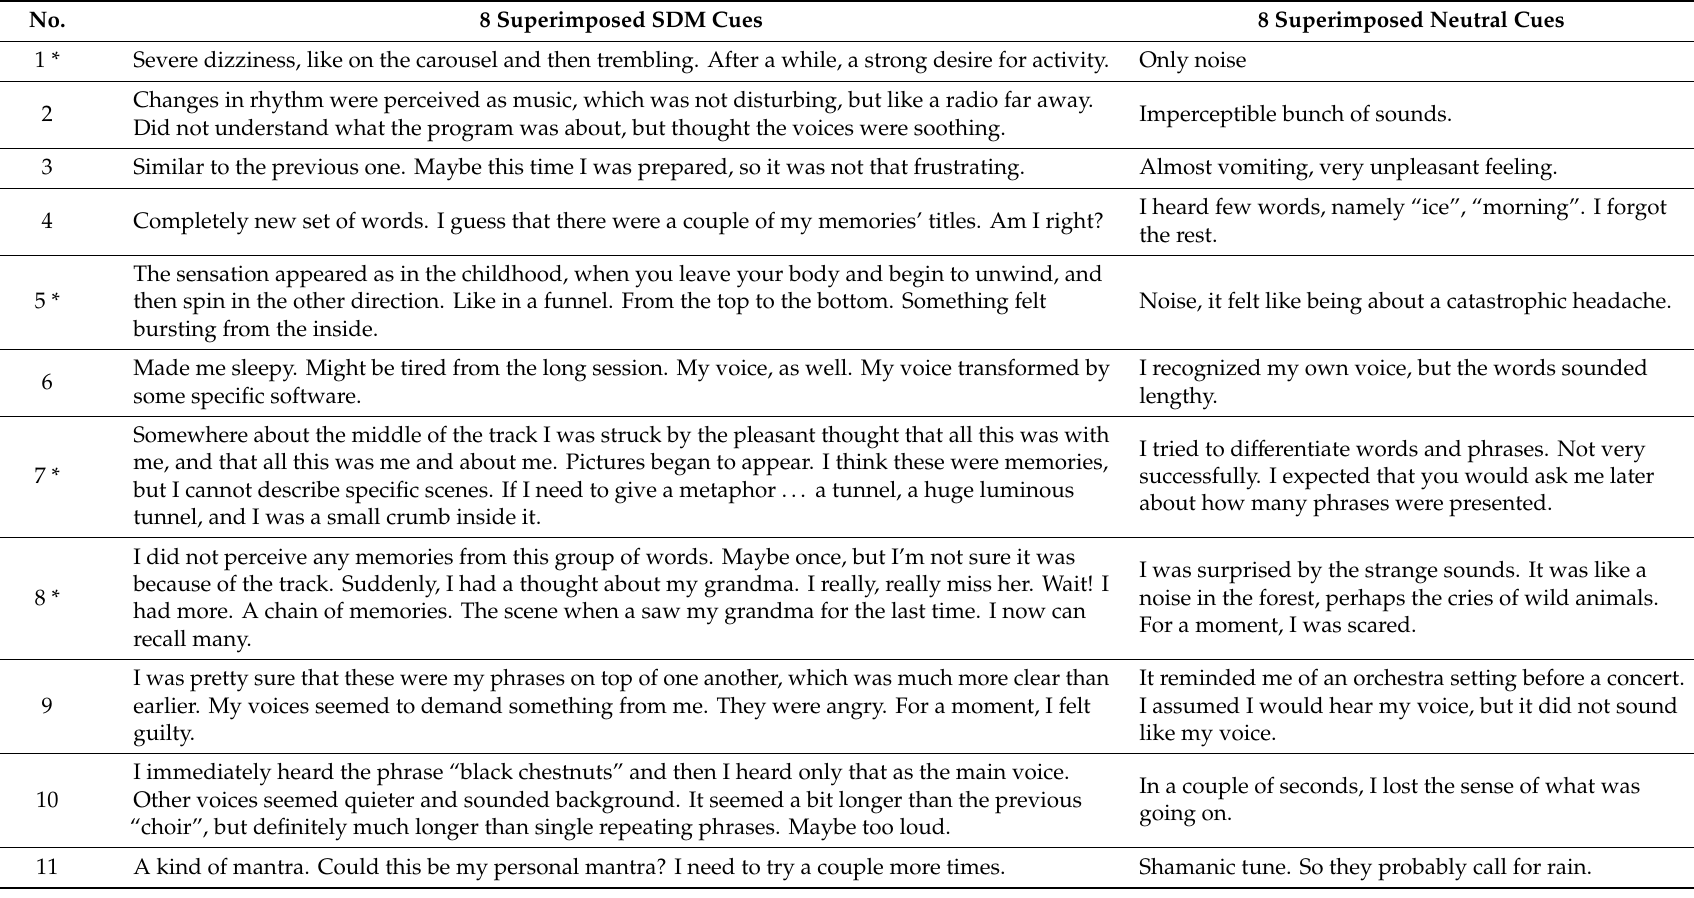
Table 1. Self-reports (excerpts) after listening to eight superimposed self-defining memories (SDM) cues or to eight superimposed neutral phrases (direct quotes translated from Russian). The participants in the “compressed life review (CLR) experiencers” group are marked by an